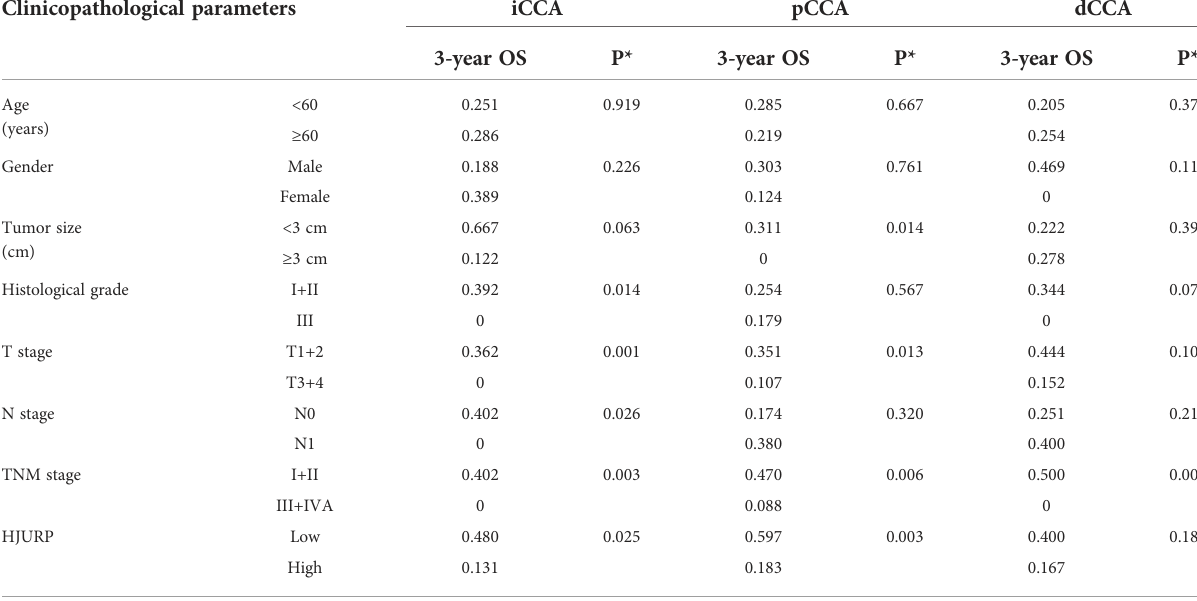
TABLE 3 The prognostic signi fi cance of HJURP and clinicopathological factors of CCA. Clinicopathological